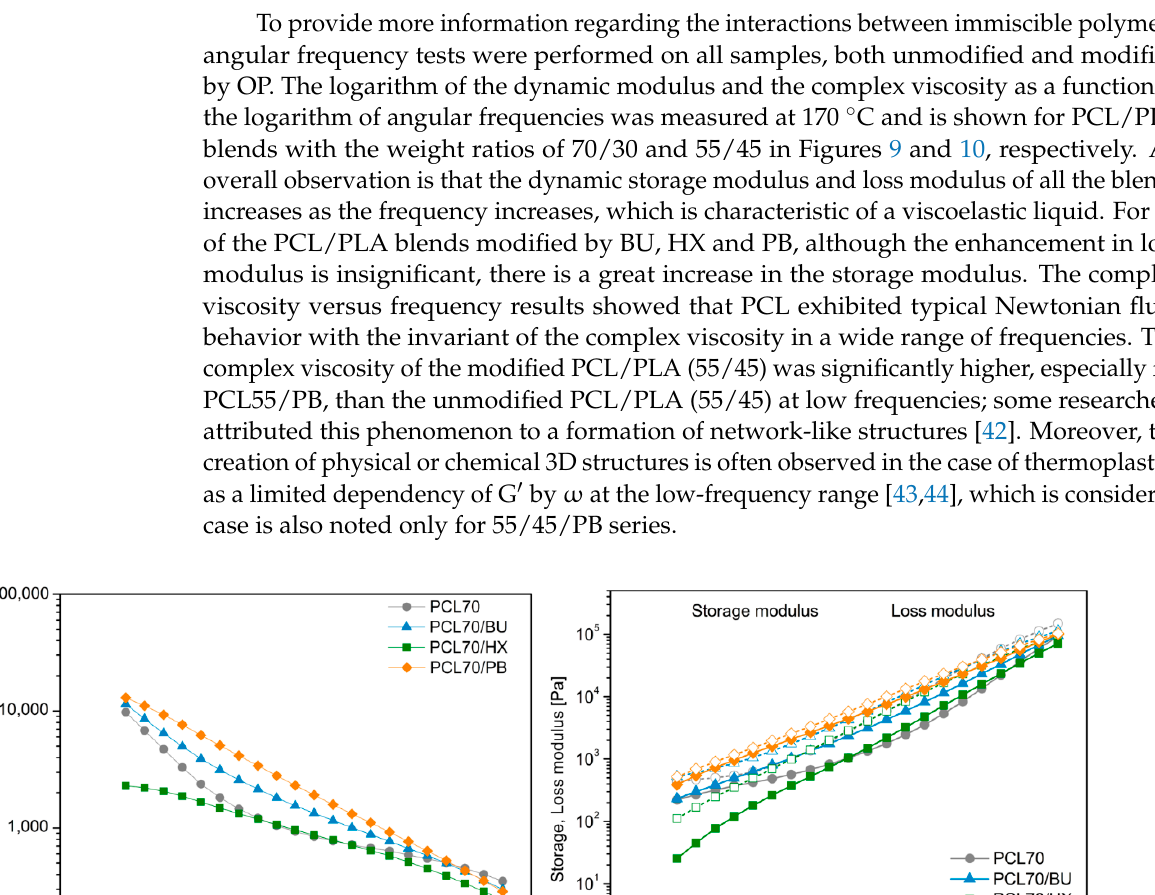
Figure 8. Cole–Cole plots for PCL/PLA blends at various weight ratios ((70/30) and (55/45)) and modified by OP.